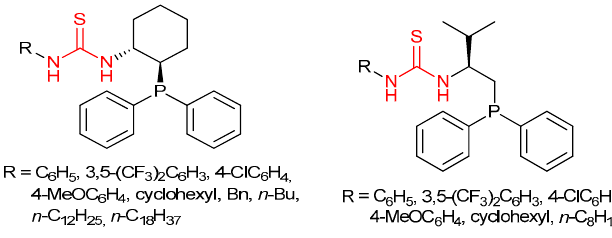
Figure 23. Chiral thioureas with diphenylphosphine moiety [302,303].